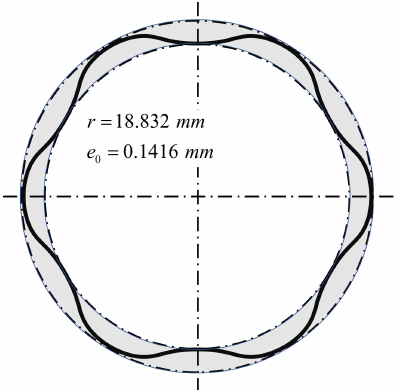
Figure 11. Modified M-T04 profile investigated in [2].